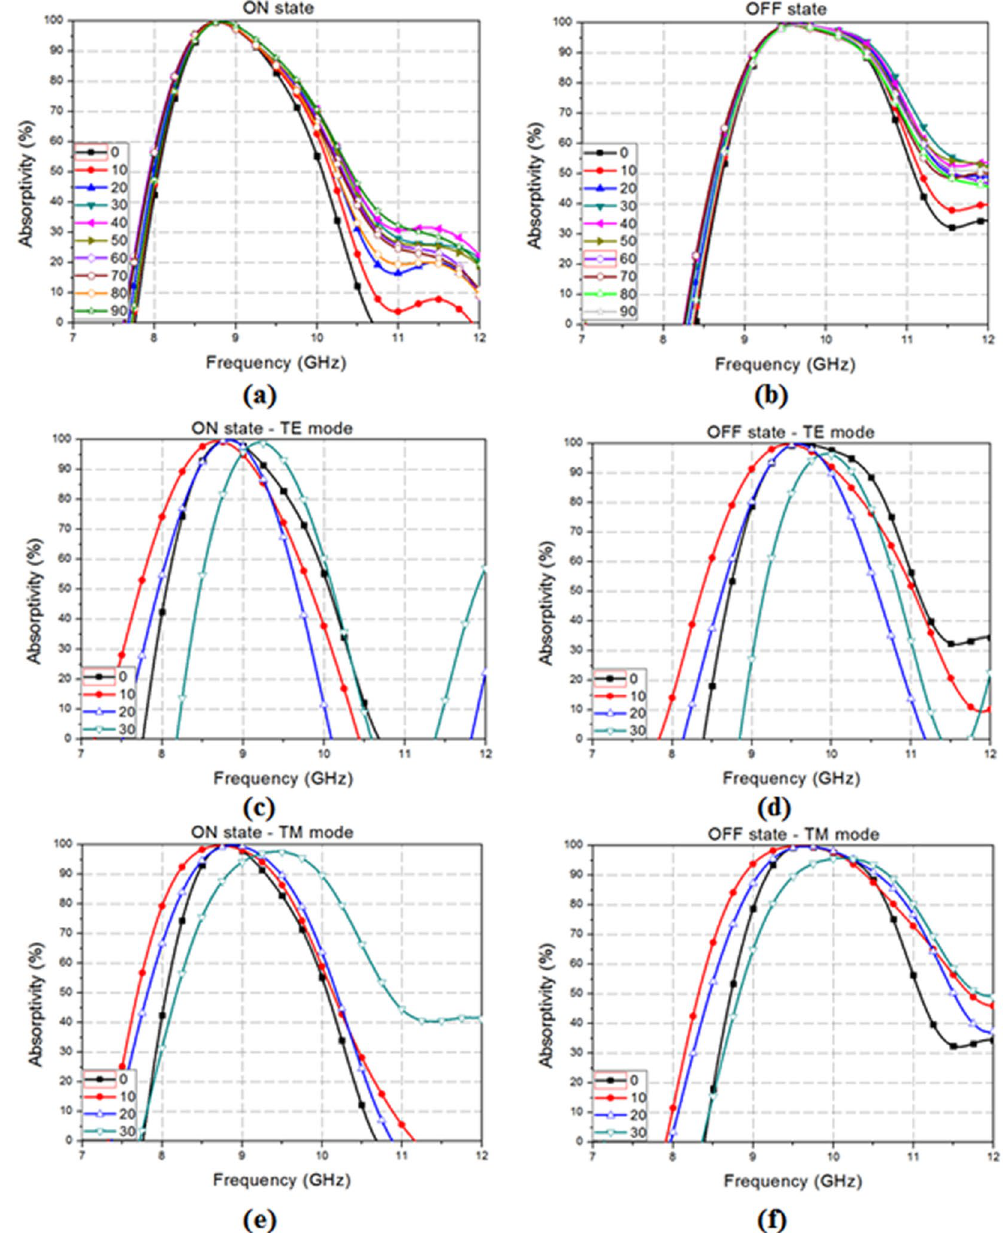
Figure 8. Measured absorptivity at different polarization angles ( ϕ ) at (a) ON state and (b) OFF state, at different incident angles ( ϕ ) for TE mode at (c) ON state and (d) OFF state, for TM mode at (e) ON state and (f) OFF